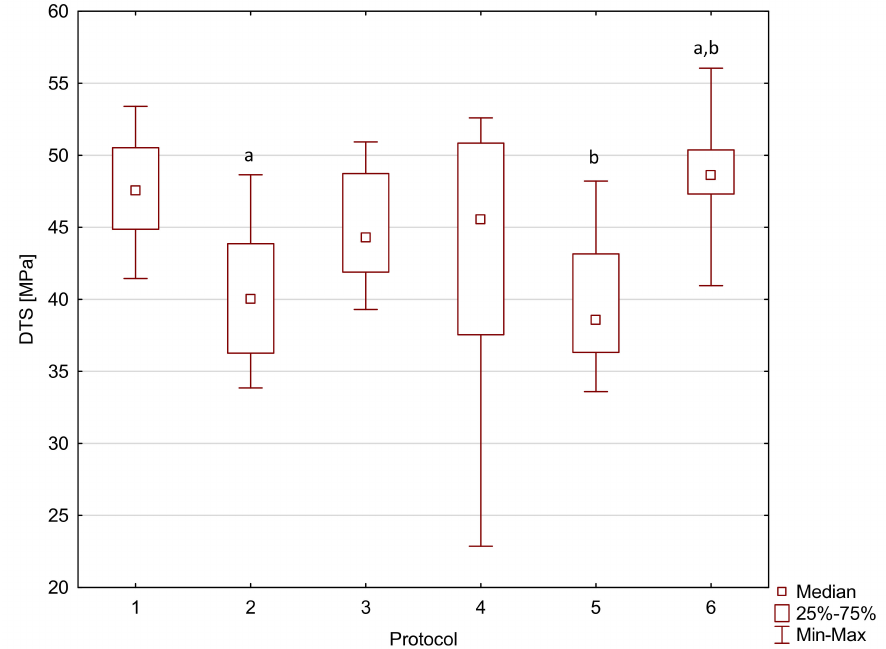
Figure A5. Box-and-whisker plot of diametral tensile strength (DTS) of Flow-Art material. Statistically-significant differences were detected between the following: (a,b) Protocol 6 (water, 5 days, 55 ◦ C) vs. (a) Protocol 2 (artificial saliva, 90 days, 37 ◦ C) ( p = 0.028899); (b) Protocol 5 (0.1 M NaOH, 7 days, 60 ◦ C) ( p =